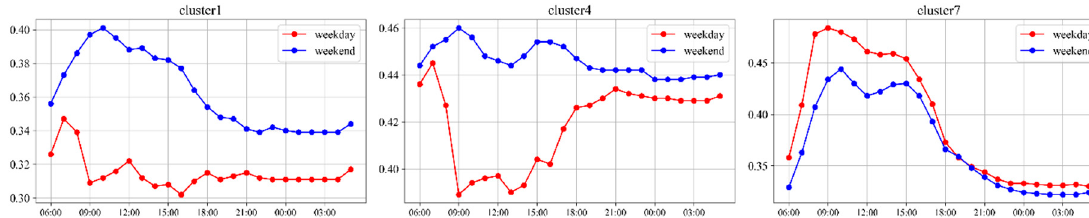
Figure 10. The daily temporal demand pattern of different clusters when k = 8.